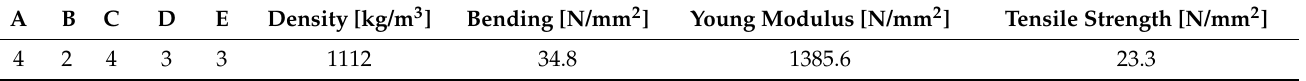
Table 7. Mechanical properties of the obtained optimum model of the waste based composite material.